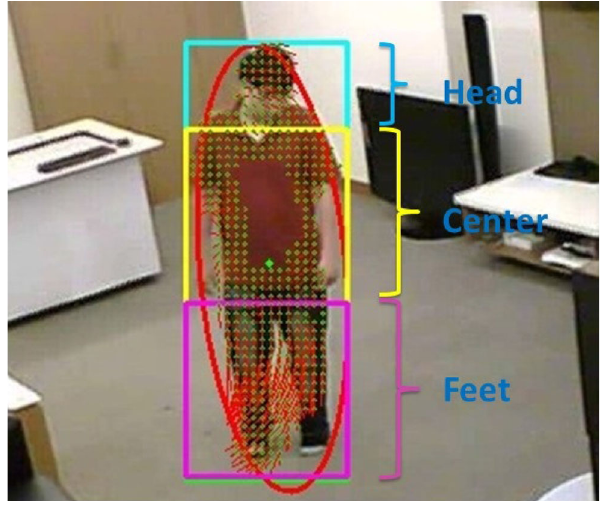
Fig. 2 Our three block representation for human body shape and motion.